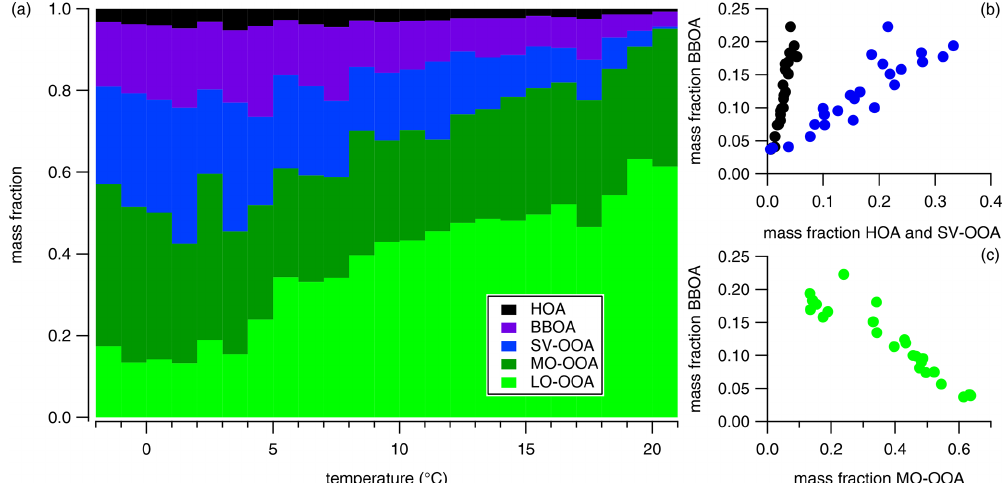
Figure 6. Temperature dependency of the identified factors’ contribution to OA (a) , and their individual correlations (b, c) . The OA mass concentrations were averaged to a 1 ◦ C resolution. Table 1. Properties of the different air mass